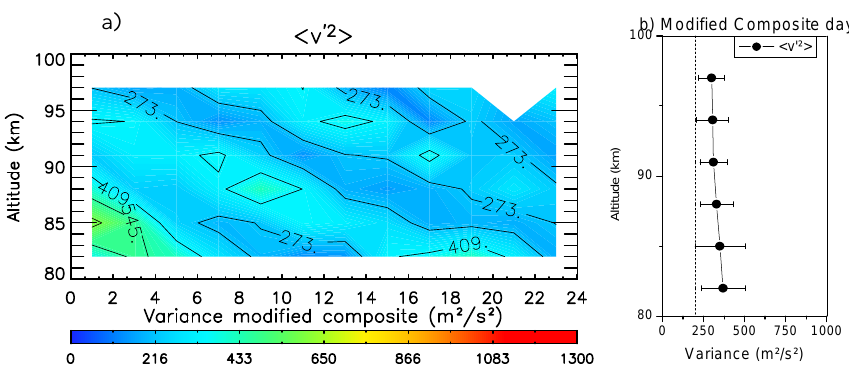
Fig. 4. As Fig. 2, but using the modified composite day analysis. Table 1. Mean, tidal, planetary wave, and GW parameters* used for test cases evaluating modified composite day of CP SKiYMET mea- surement capabilities employing real meteor distributions and test motion fields. Source: adapted from Fritts et al.